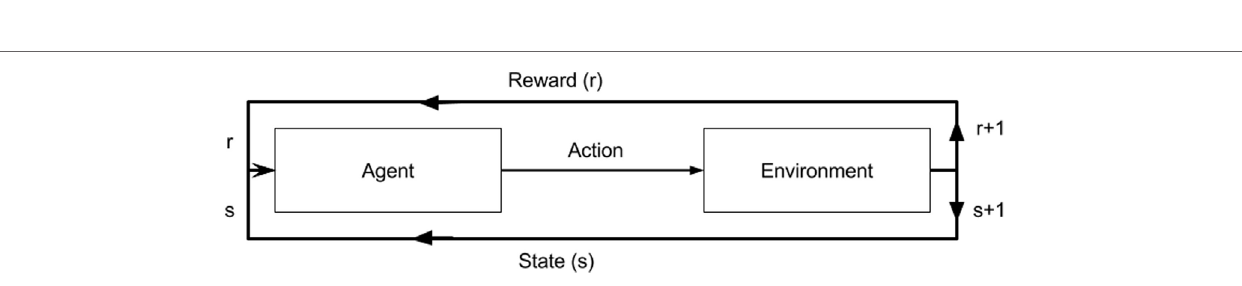
FigUre 2 | A diagram of a reinforcement model. An agent in a given state (s) and reward (r) completes an action in environment. This results in change of environment and either an increase/decrease in reward as a result of that action.